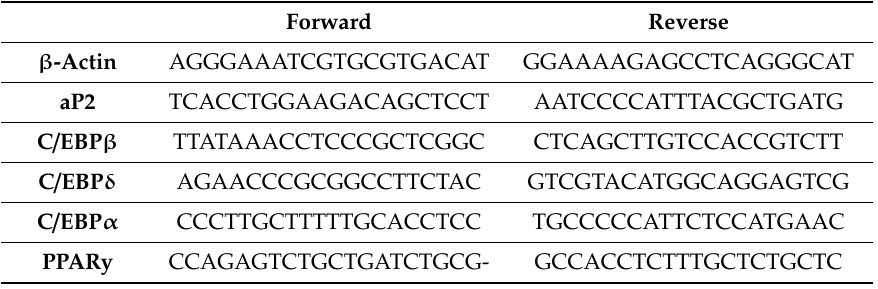
Table A1. Mouse primer sequences (5 (cid:48) -3 (cid:48) ) used for amplification. Forward Reverse β -Actin